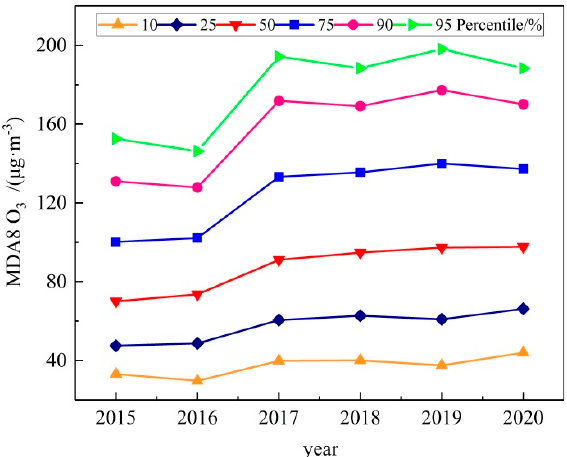
Figure 5. Percentile variation of annual MDA8 O 3 in Shanxi Province during 2015 − 2020. Drastic measures have been taken to reduce SO 2 , NOx and dust in recent years in Shanxi Province. According to the Ecological Environment Bulletin of Shanxi Province [47], SO 2 and NOx emissions in Shanxi decreased by 30.0% and 23.8%, respectively, in